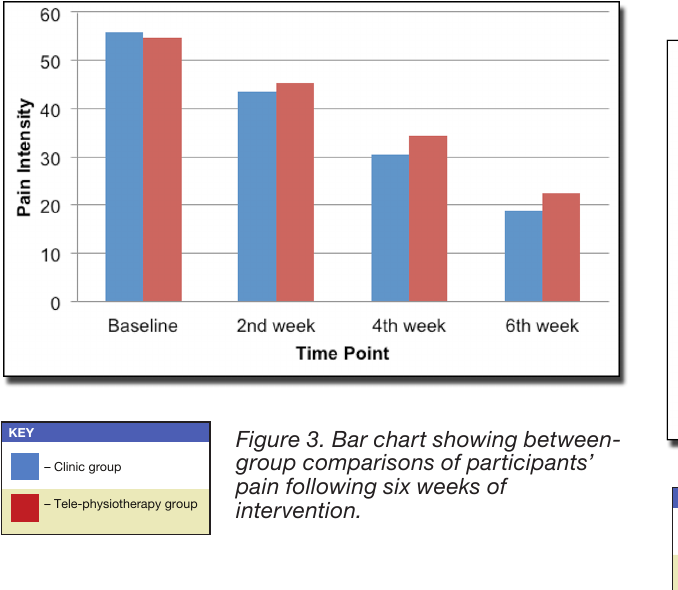
Figure 4. Bar chart showing between- group comparisons of participants’ physical function following six weeks of